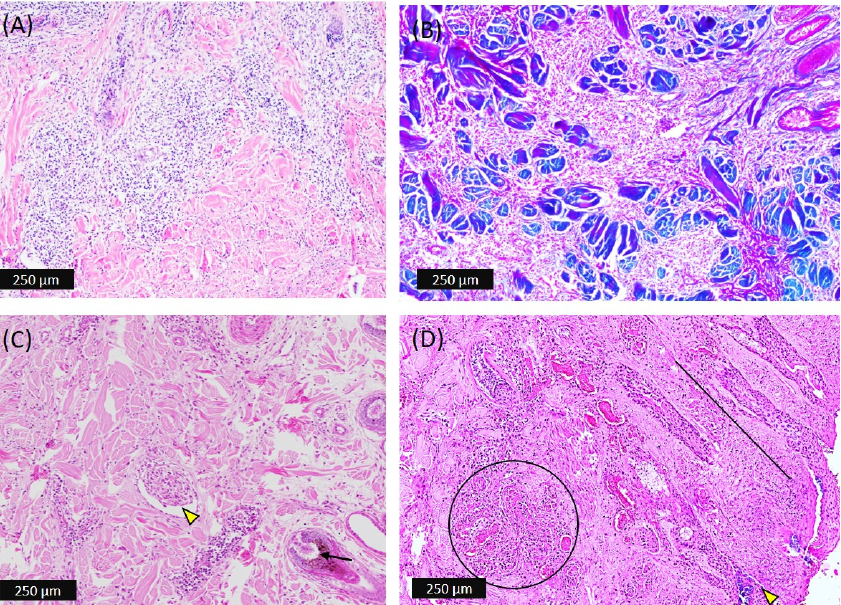
Figure 4. Microscopic pathology of the skin nodules developed in dermis of affected cattle. ( A ) Diffuse to nodular proliferation of mononuclear cells in the dense irregular connective tissue layer of dermis as well as centering the blood vessels. ( B ) Abundance of connective tissue fibers (blue) after using Masson’s trichrome stain. ( C ) The inflammatory cells adhered to lumen and around blood vessels (yellow arrowhead); the hair follicles’ epithelial cells are degenerated and hyperplastic (black arrow). ( D ) Dermis showing massive necrotizing dermatitis with multiple infarcts (black circle) and formation of excretory sinuses (black line) with invaded bacteria (yellow arrowhead). In the subcutis, the pannicular fat was severely affected and a hemorrhagic infarct